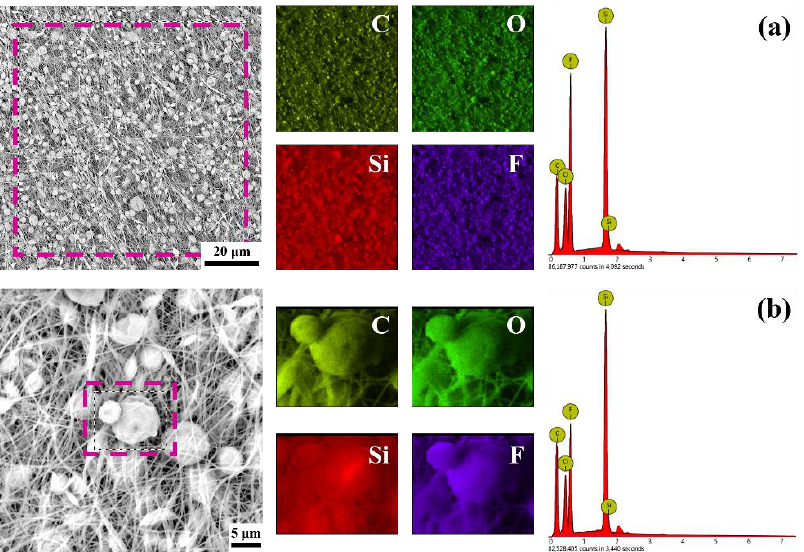
Figure 3. EDS analysis of membrane P3. ( a ) EDS analysis of the entire membrane. ( b ) EDS analysis of the microspheres.